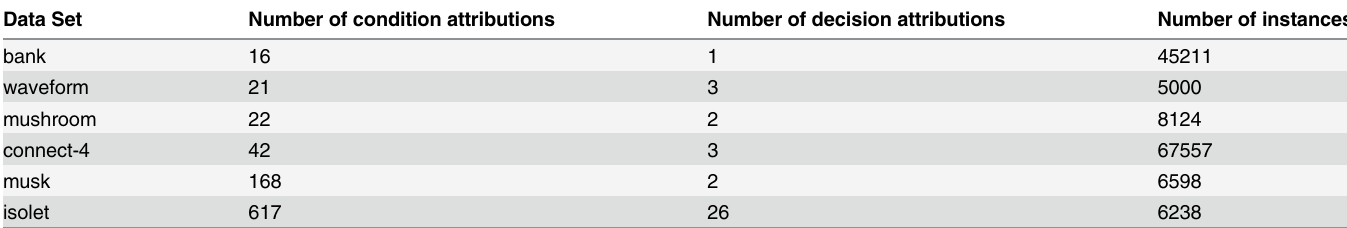
Table 2. Data sets used in our